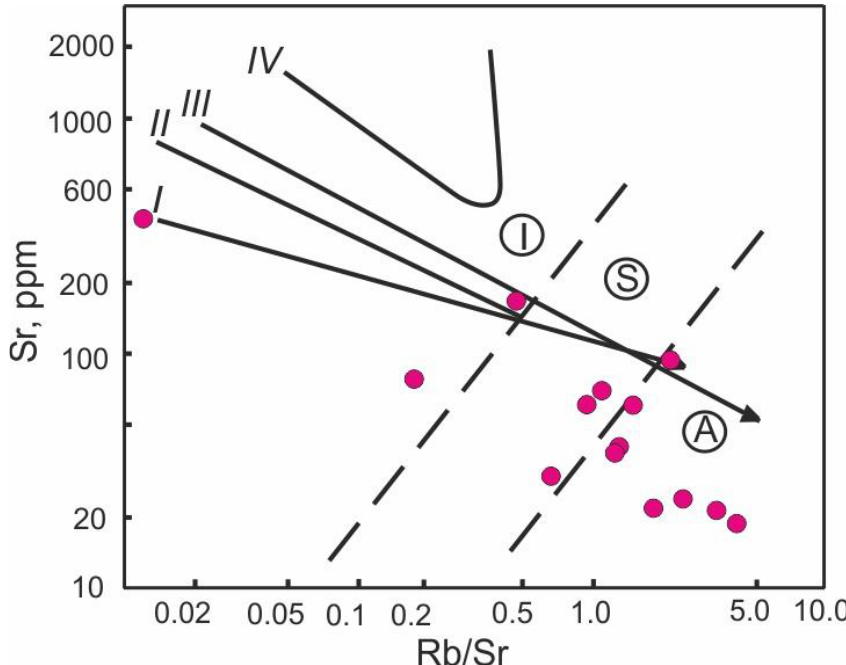
Figure 14. Sr vs. Rb/Sr diagram for granites of the Somnitelnyi massif. Differentiation trends for granitic series [60]: I—island-arc tholeiitic; II—island-arc calc-alkaline; III—active margin calc-alkaline; IV—continental rift zones; and I, S, A—petrographic types of granitoids.